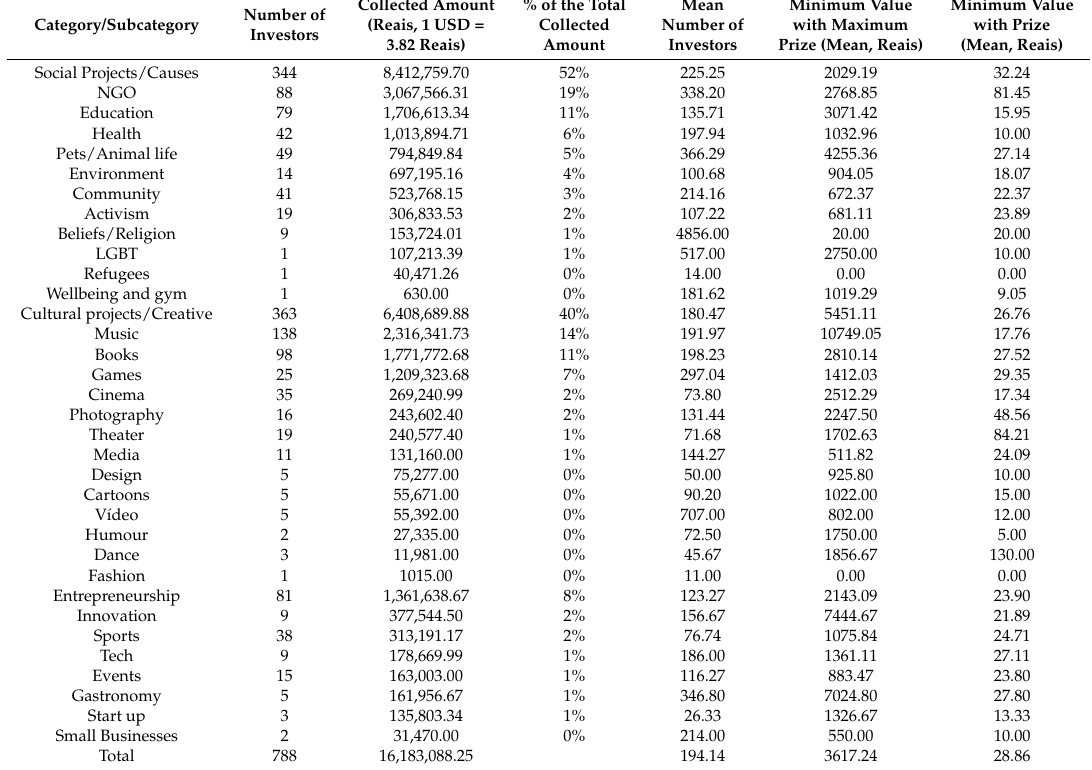
Table 1. Descriptive values for successful Kickante projects